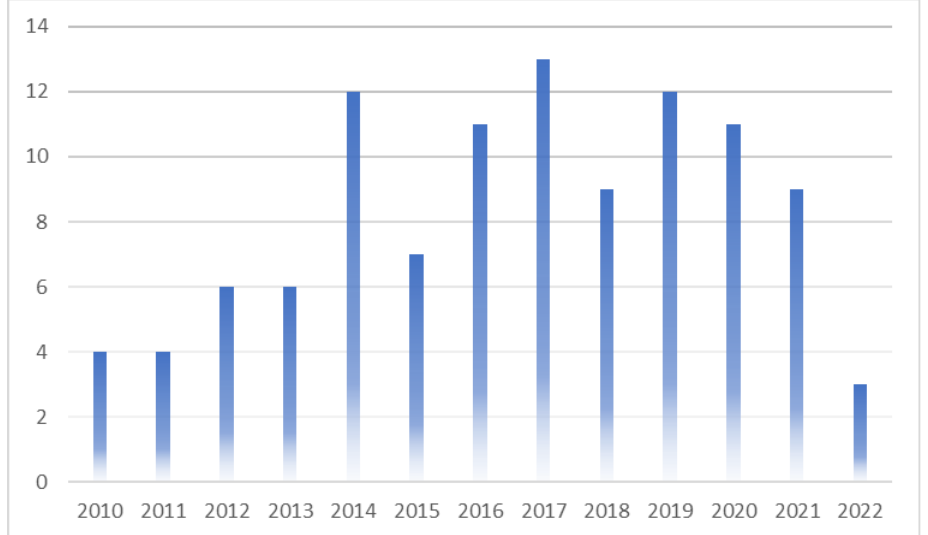
Figure 4. Frequency of publications on the use of motion capture in ergonomics between 2010 and 2022. Source: own processing.